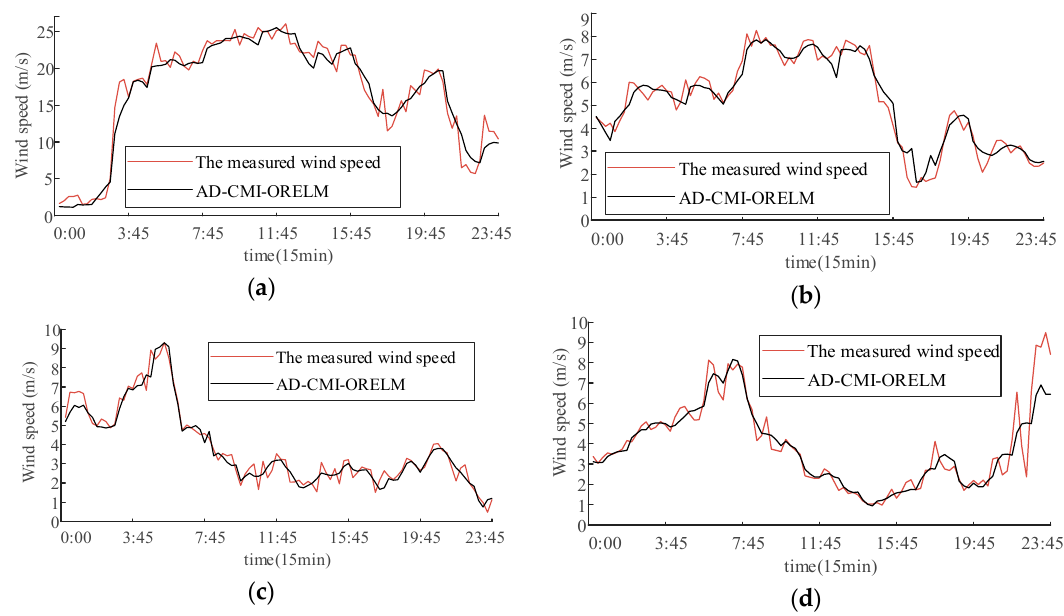
Figure 7. Predicts curves of the proposed method on different predict days ( a ) Forecast curve of 21 January; ( b ) Forecast curve of 17 April; ( c ) Forecast curve of 18 July; ( d ) Forecast curve of 7 November.